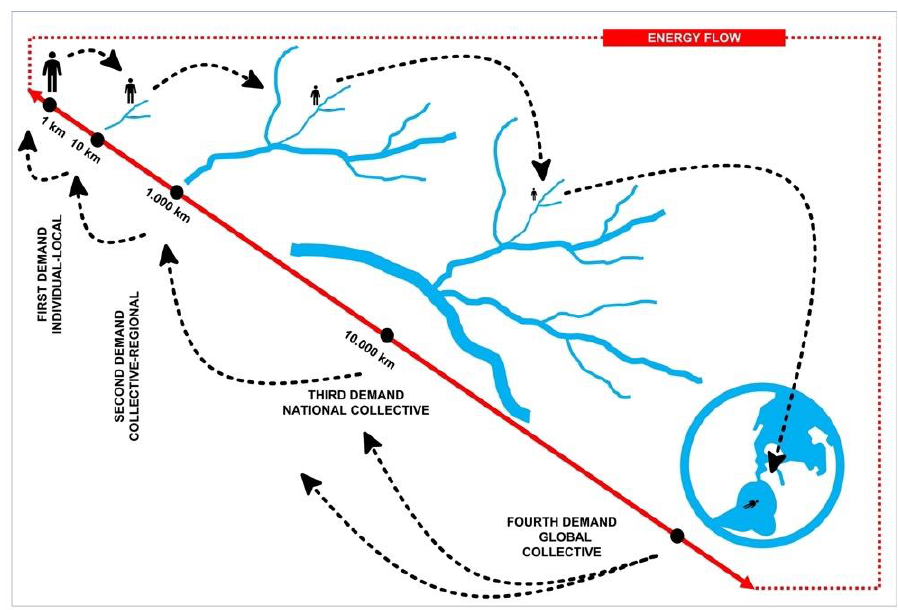
Figure 1. Multilevel analysis proposal. (Source: authors).